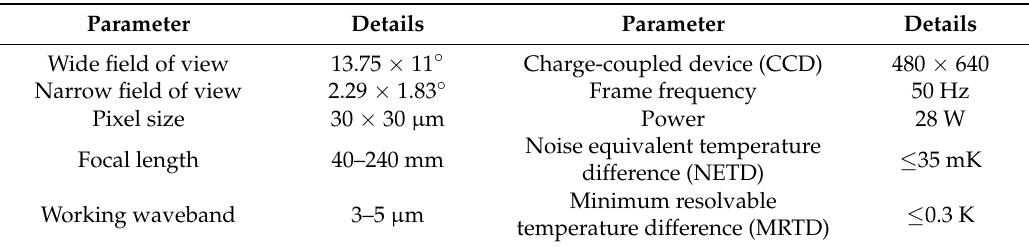
Table 1. Medium-wave infrared thermal imager parameters.